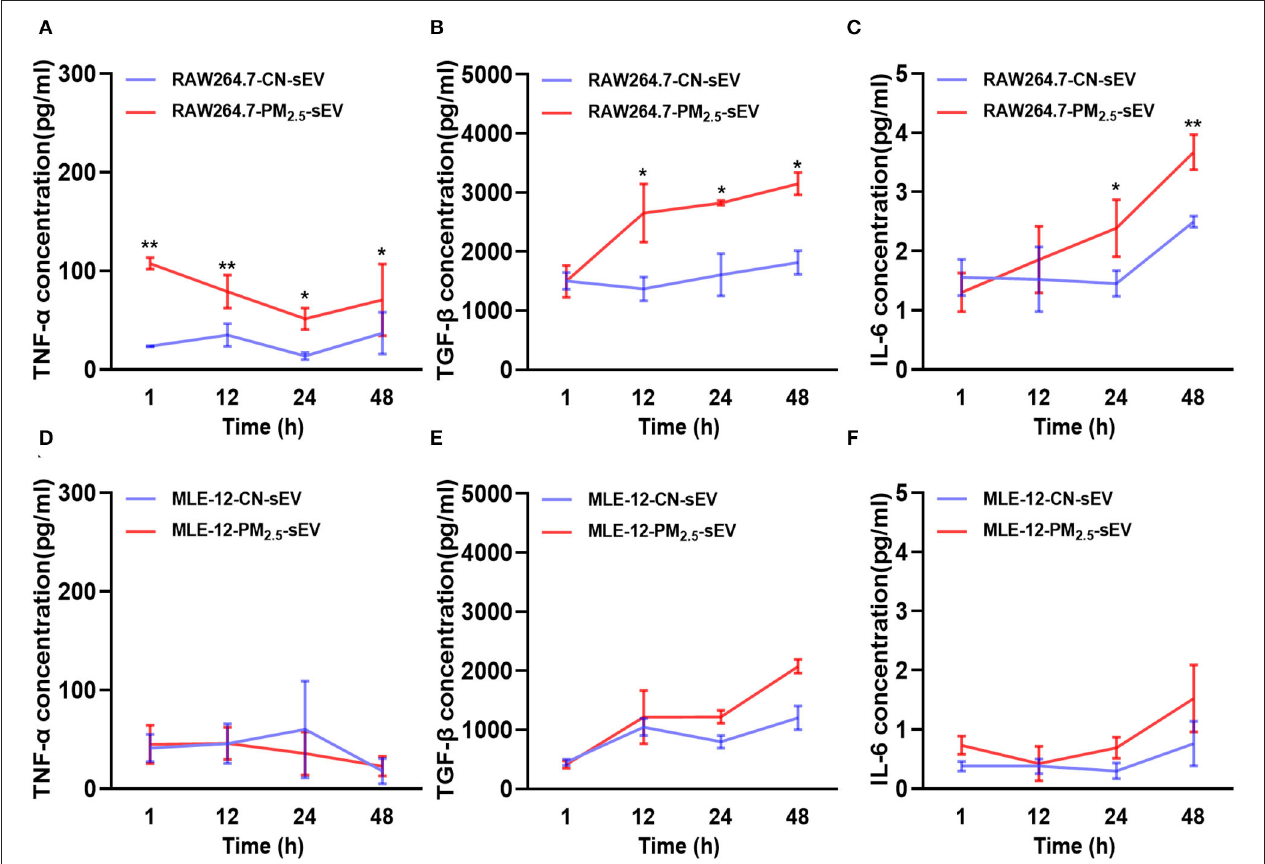
FIGURE 5 | Release of key cytokines in sEV by RAW264.7 and MLE-12 after 1, 12, 24, 48h of PM 2.5 exposure. (A–C) ELISA for TNF α , TGF- β , and IL-6 in sEV from RAW264.7 cells after 1, 12, 24, and 48h of PM 2.5 exposure. (D–F) ELISA for TNF α , TGF- β , and IL-6 in sEV from MLE-12 cells at 1, 12, 24, and 48h after PM 2.5 exposure. All the data were presented as mean ± SEM (two-way ANOVA), n = 3. *indicates p < 0.05, **indicates p < 0.01.